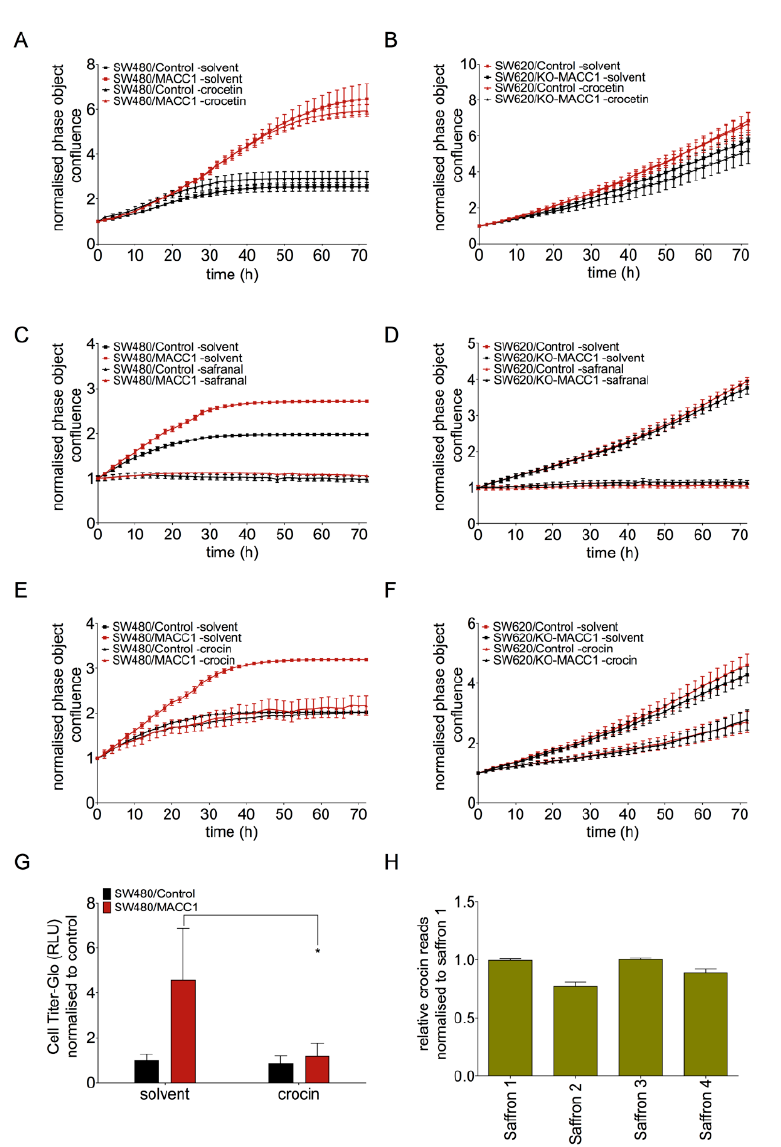
Figure 4. Crocin reproduced the MACC1-dependent effect of saffron. Cells were treated with different crocetin concentrations. Crocetin did not reduce the proliferation of both MACC1 high and low expressing cells ( A , B ). Safranal reduced the proliferation rate of both cell lines in a MACC1-independent manner ( C , D ). Crocin decreased the proliferation rate of the CRC cells with high MACC1 level ( E , F ). In addition, migration reduction in high MACC1-expressing CRC cells was observed under crocin treatment in Boyden chamber assay ( G ). Following this, via chromatography analysis, the direct read of crocin extract of each saffron was established. High variation of crocin has been observed between the four different saffron extracts ( H ). Data are represented as mean ± SEM ( n ≥ 3). P values were calculated using Student’s t -test. * p < 0.05.